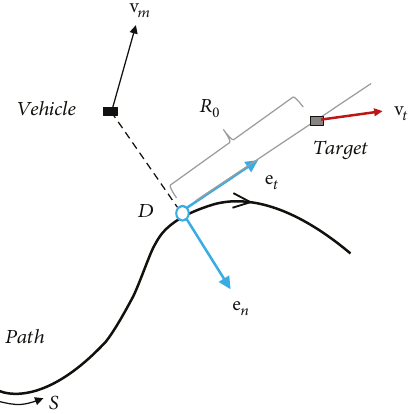
Figure 3: Continuous curvature path